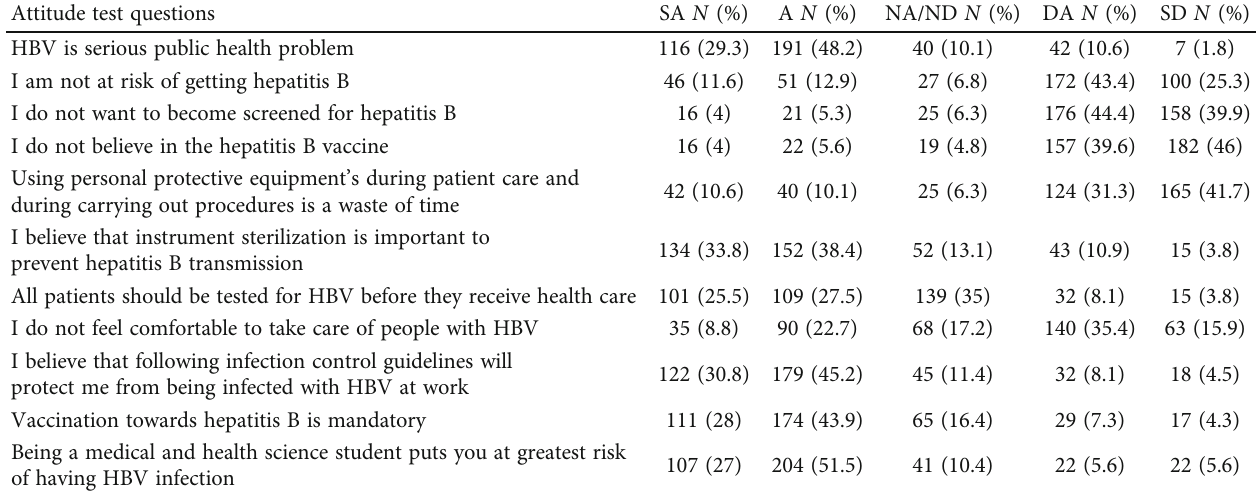
Table 3: Frequency distribution of students ’ attitude score by Likert scale regarding HBV infection prevention at HUCMHS, Hawassa, Ethiopia, 2021 ( n = 396 ).